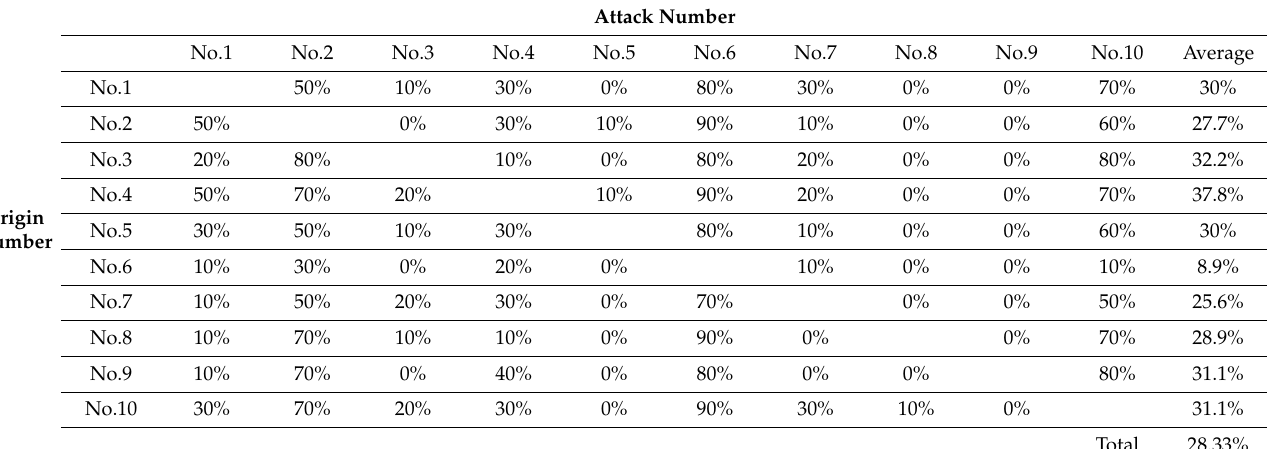
Table 17. Impersonation attack success rate after defense.